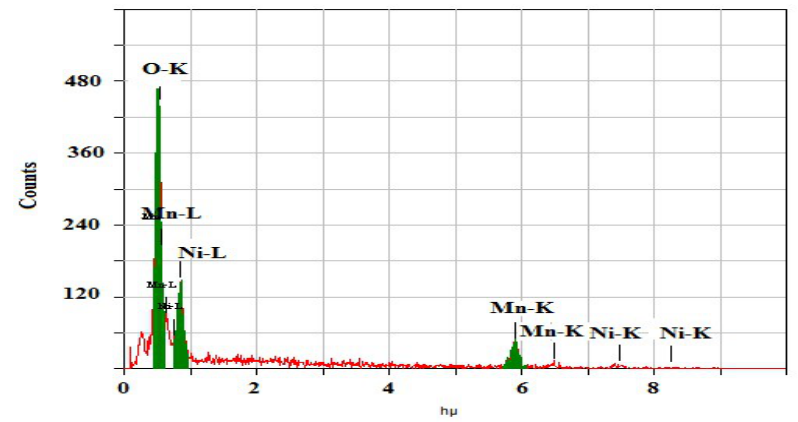
Figure 6. EDS pattern of S4 sample.